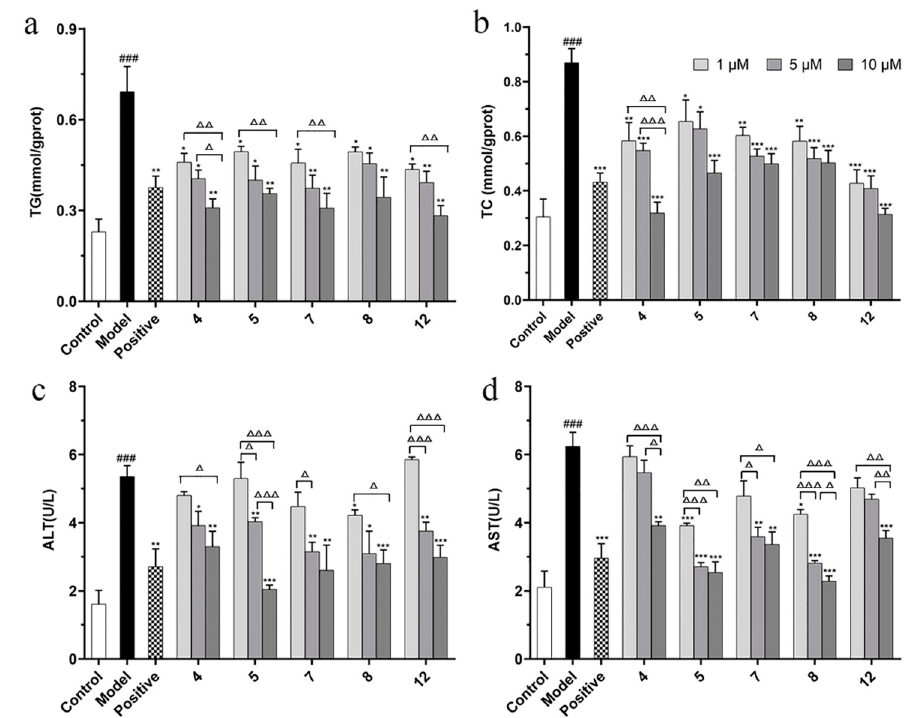
Figure 6. The effects of compounds ( 4 , 5 , 7 , 8 , and 12 ) on TG ( a ), TC ( b ), ALT ( c ), and AST ( d ) level in FFA-induced BRL cells. BRL cells were treated with a mixture of 0.5 mM FFA in the absence or presence of compounds ( 4 , 5 , 7 , 8 , and 12 ) at the concentration of 1, 5, or 10 μ M. The values are presented as mean ± SEM of six independent experiments. ### p < 0.001, vs. the control group; * p < 0.05, ** p < 0.01, *** p < 0.001, vs. the model group. Δ p < 0.05, ΔΔ p < 0.01, ΔΔΔ p < 0.001, pairwise comparisons between three doses of each compound group.